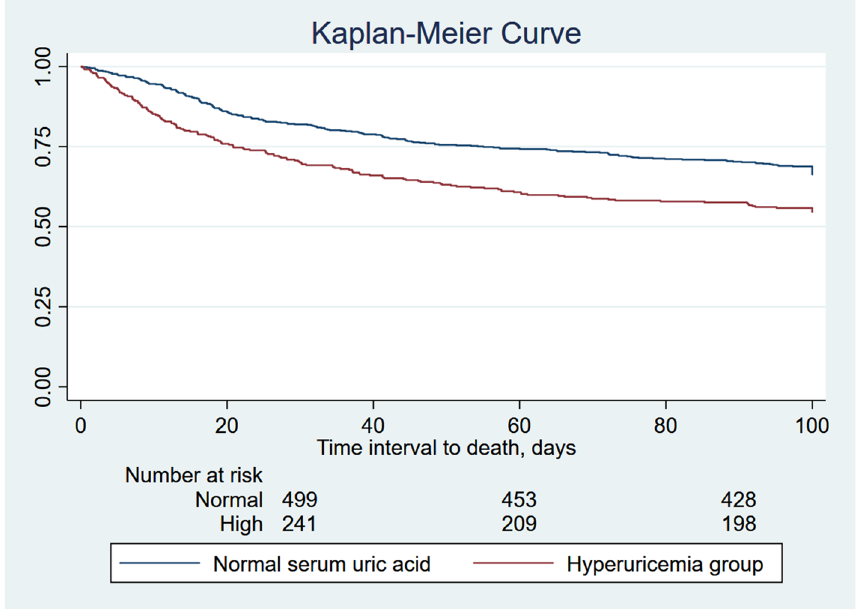
Figure 4. Kaplan–Meier curve was used to evaluate the difference in 90-day all-cause mortality in patients with sepsis with normal serum uric acid levels and hyperuricemia in critical care units. In the Kaplan–Meier analysis, the log-rank test p value <